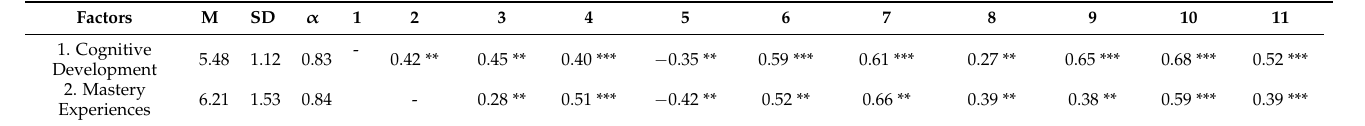
Table 2. Descriptive statistics, reliability, and correlations between all